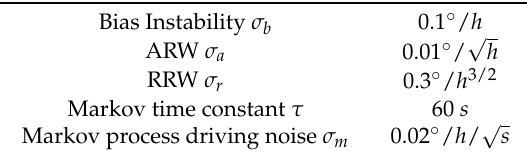
Figure 1. ( a ) Measurements of a HRG in 10Hz; ( b ). Allan variance of the HRG. The parameters of the error models for the Coriolis vibration gyroscopes in an IMU based north-finding system are given in Table 1. Table 1. Parameters of the error models for the Coriolis vibration gyroscopes (a kind of cost effective HRG in this paper).